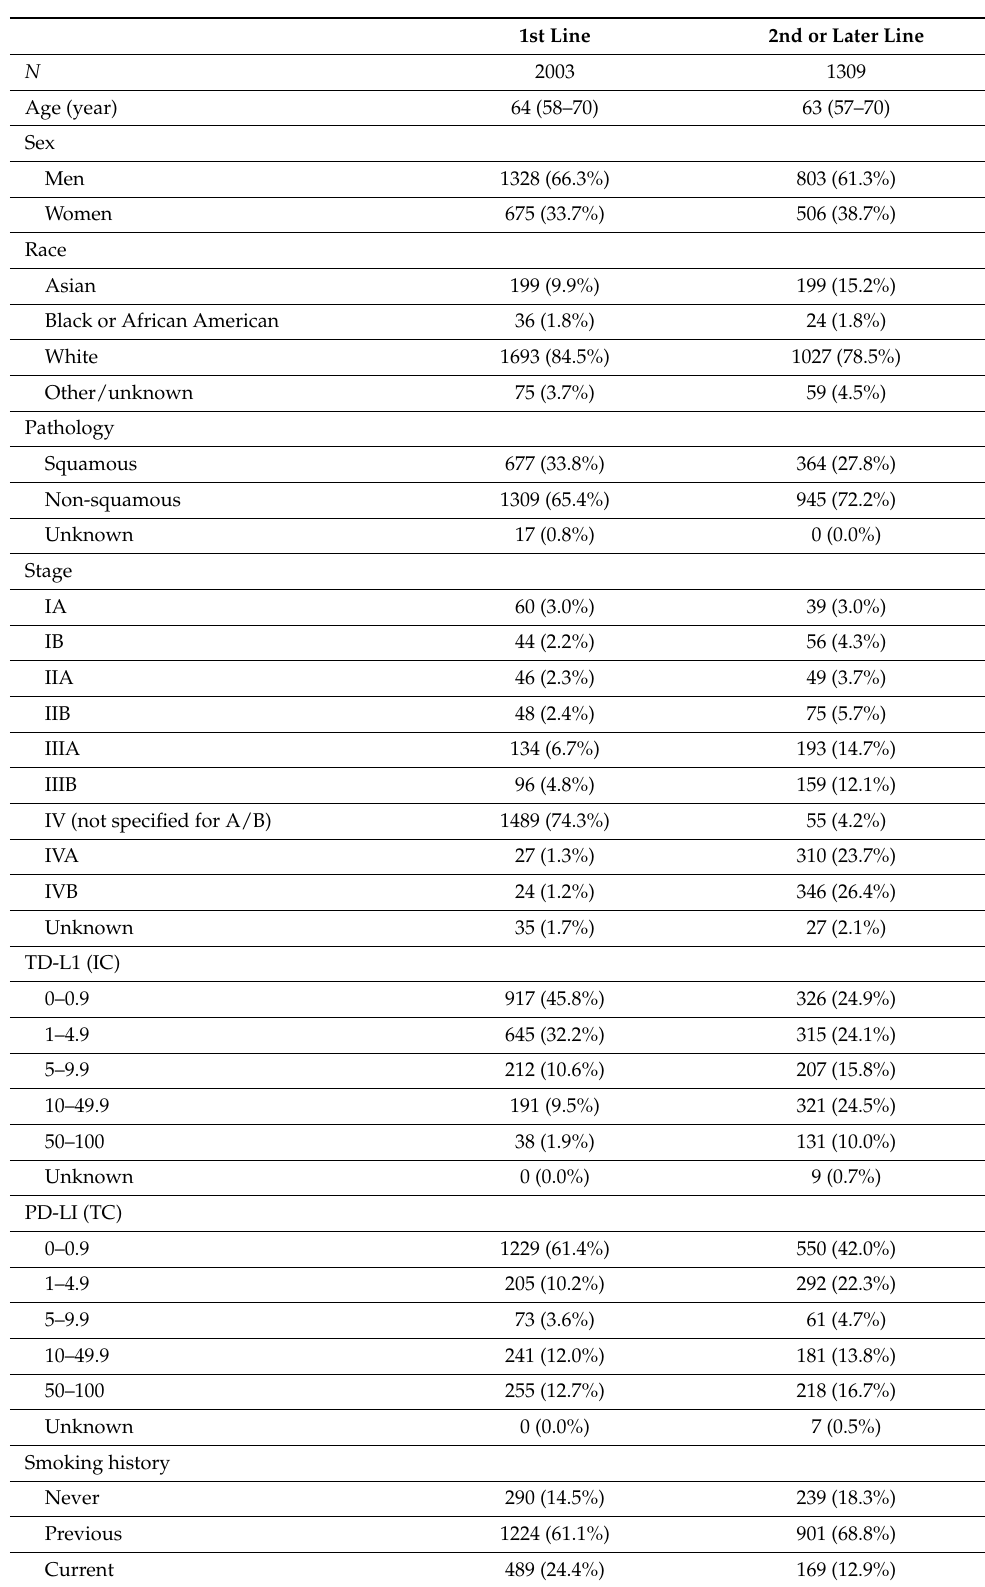
Table 1. Patient characteristics for independent patient data